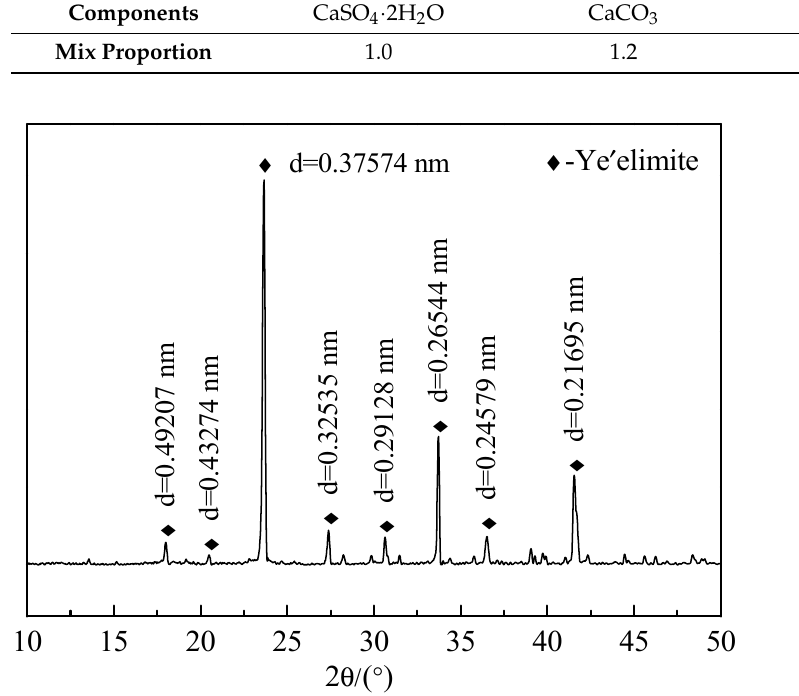
Figure 1. The XRD pattern of synthesized ye’elimite. Table 1. Mix proportion of C 4 A 3 S(cid:3364) raw material.